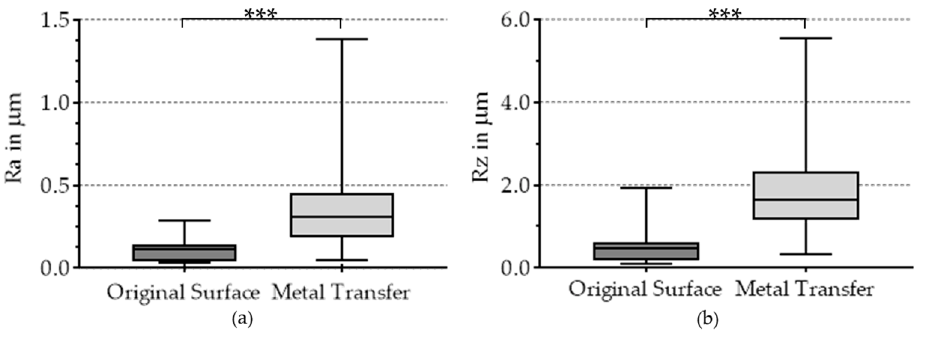
Figure 4. Results of the surface analyses of the ceramic heads with ( a ) arithmetic average roughness Ra and ( b ) maximum height Rz; highly significant differences marked with three asterisks.